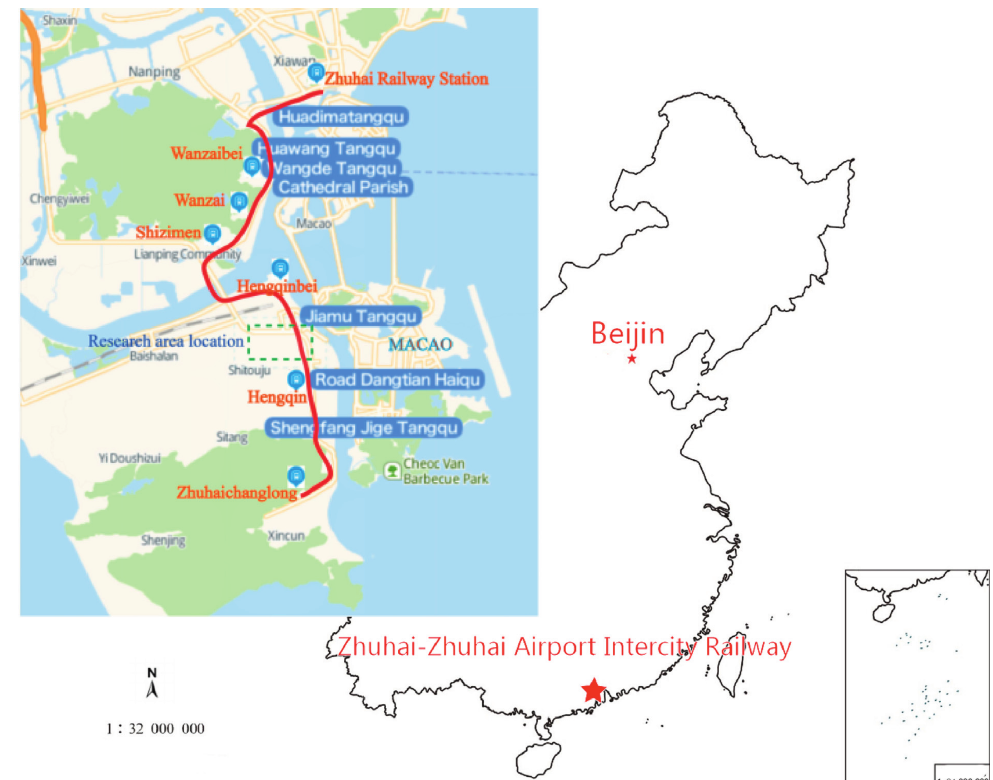
Figure 1: Zhuhai-Zhuhai Airport Intercity Railway.